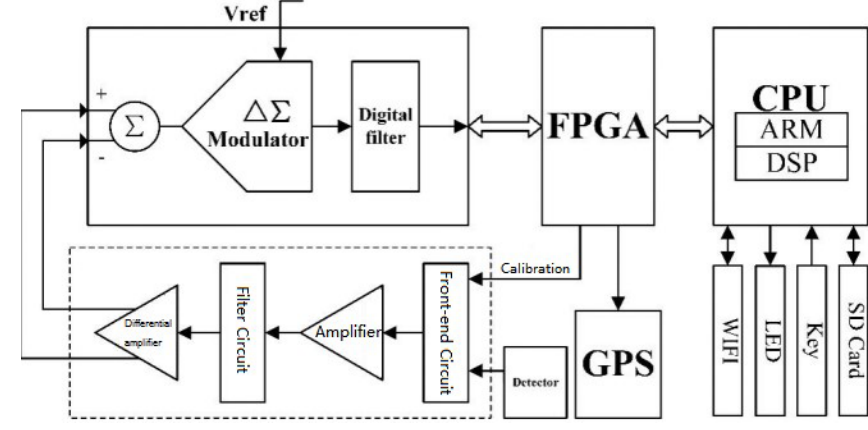
Figure 1. Overall architecture of the acquisition